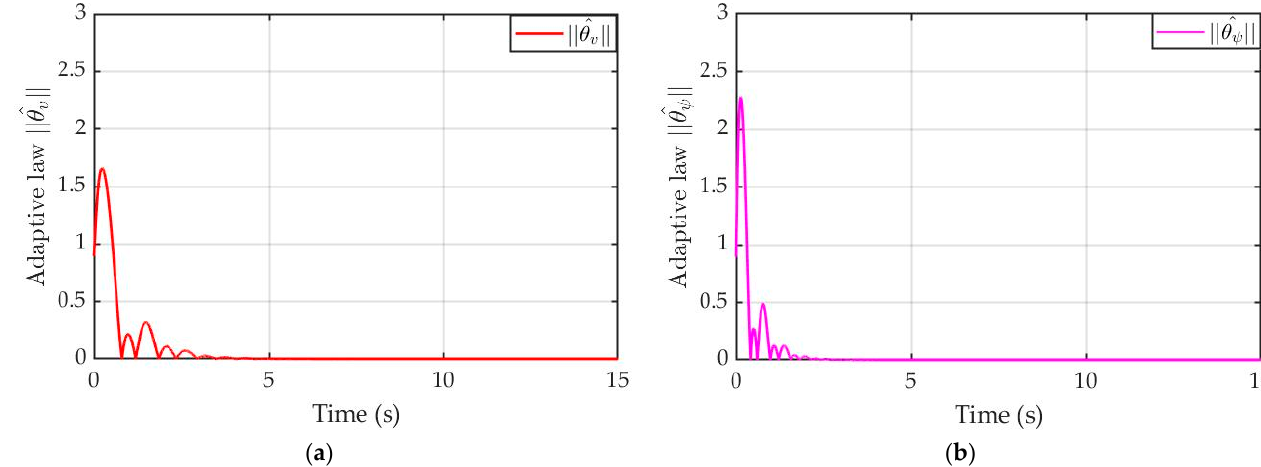
Figure 11. Adaptive law: ( a )